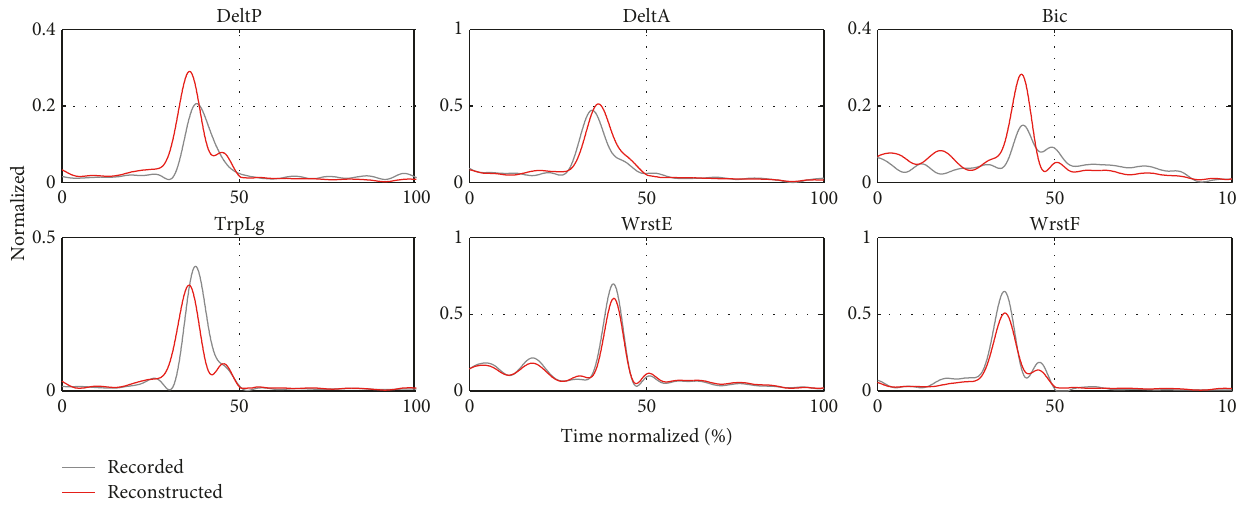
C II,All and II,All t .